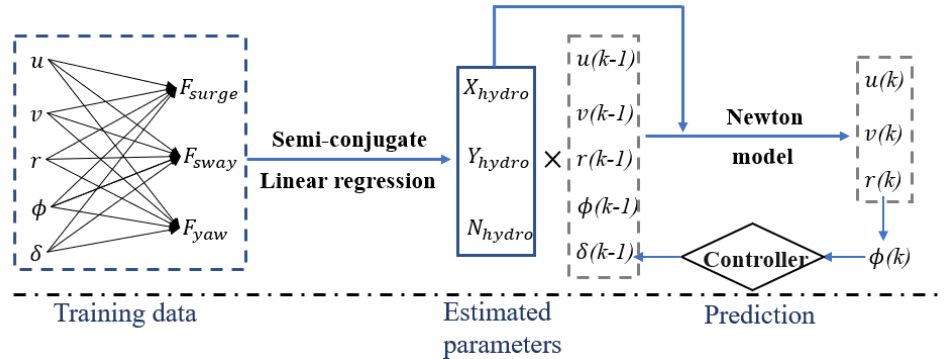
Figure 3. Process of parametric gray-box modeling using ScBR.